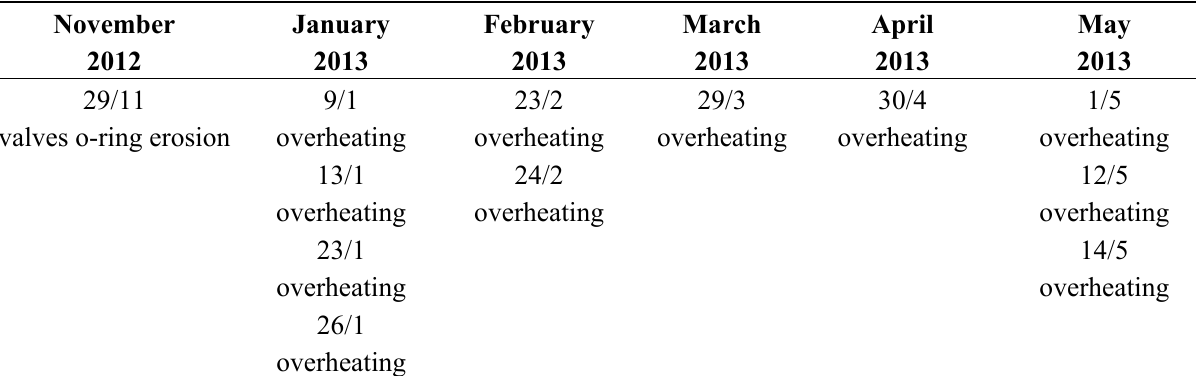
Table 2. The breakdowns of Elevator III.